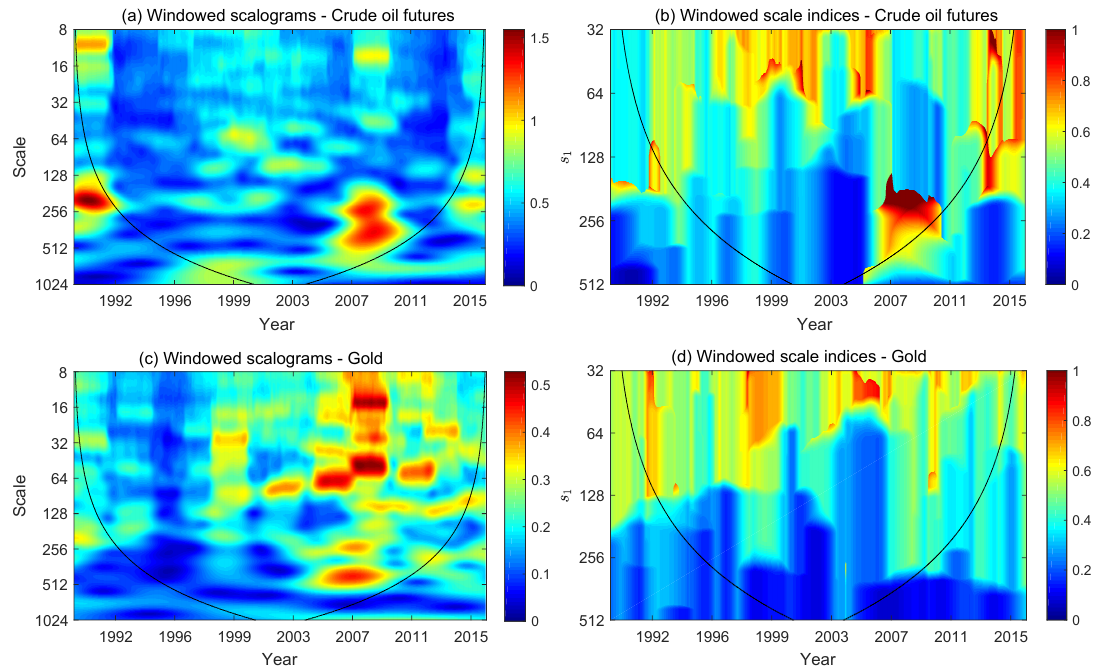
Figure 8. ( a ) Windowed scalograms and ( b ) windowed scale indices of crude oil futures contracts price returns. ( c ) Windowed scalograms and ( d ) windowed scale indices of gold futures contracts price returns. The windowed scalograms are centered at different times with time radius τ = 300 days. The windowed scale indices are centered at different times with time radius τ = 300 days, taking s 0 = 8 days and different values of s 1 from 32 to 512 days. The cone of influence outside which there are border effects is also represented with a black line in all